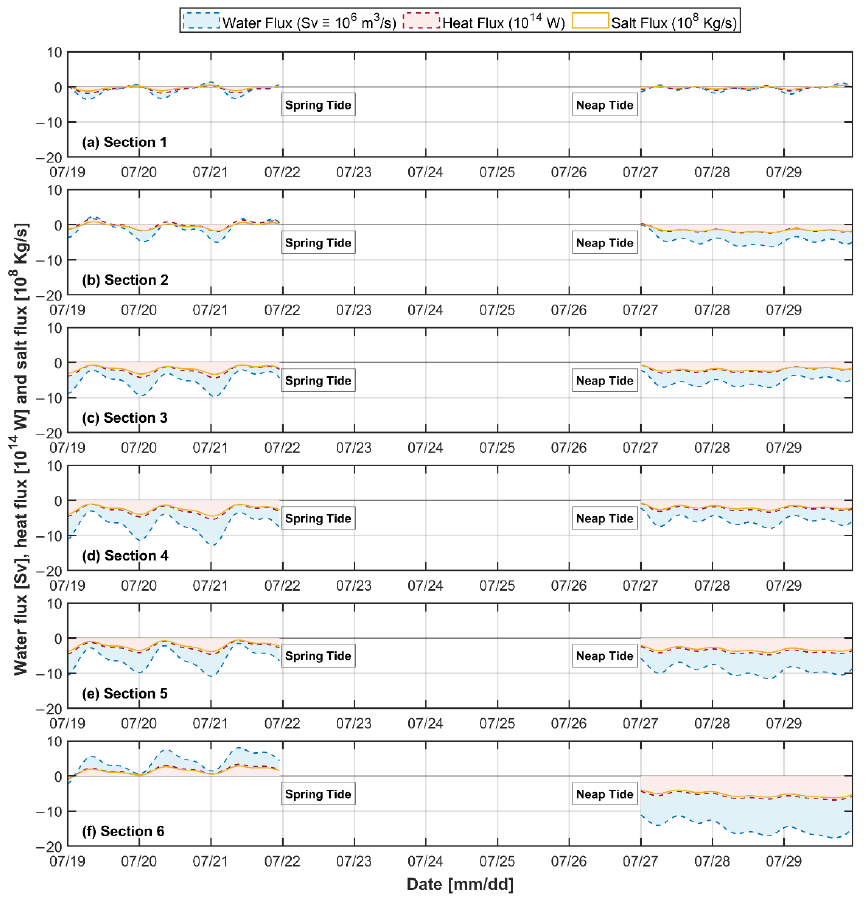
Figure 8. Water flux (blue area), heat flux (pink area), and salt flux (yellow line) in Sections 1 – 6 of Figure 1c during the spring tide (19 – 22 July) and neap tide (27 – 29 July). A positive value indicates mass transport into the section, while a negative value indicates mass transport out of the section.